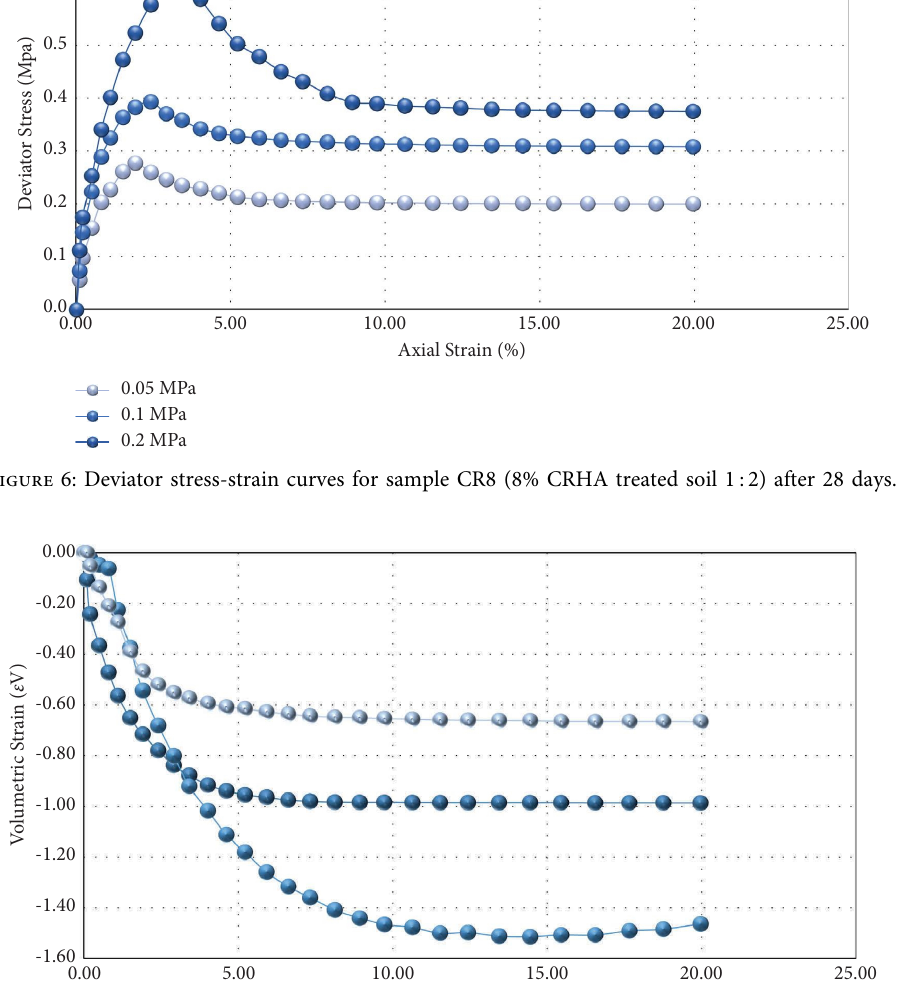
Figure 9. At this stage, an axisymmetric model with 15 nodes was applied to simulate a cylindrical specimen measuring 100 mm in height and 50 mm in diameter. Line loads were assigned to the right and top boundaries. Te lateral stresses, σ and σ , were represented by the distrib- 2 3 uted loads on the right and front, respectively. Te axial stress, σ , was represented by a distributed load on the top of 1 the model.